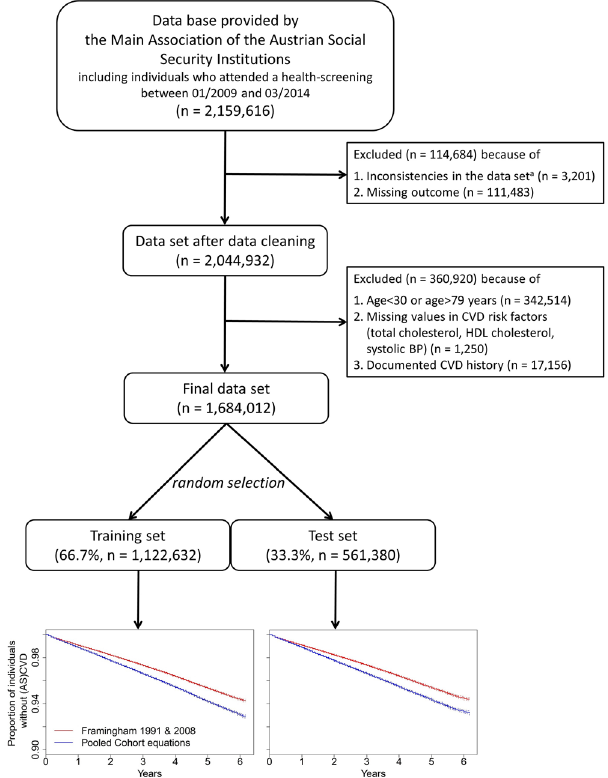
Figure 1. Flow-chart deriving the training and test set. At the bottom, Kaplan-Meier plots for the time to a first (atherosclerotic-) cardiovascular disease for the evaluated equations in the training and the test set are shown. a Individuals with inconsistencies in repeated health-screenings (sex, date of birth, or death) were